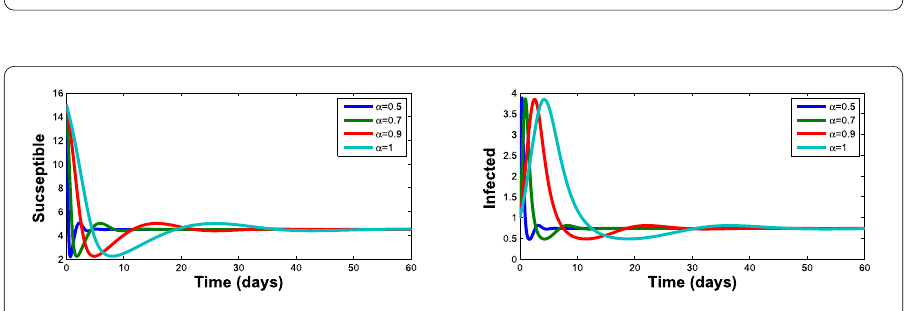
Figure 2 Stability of the endemic equilibrium E